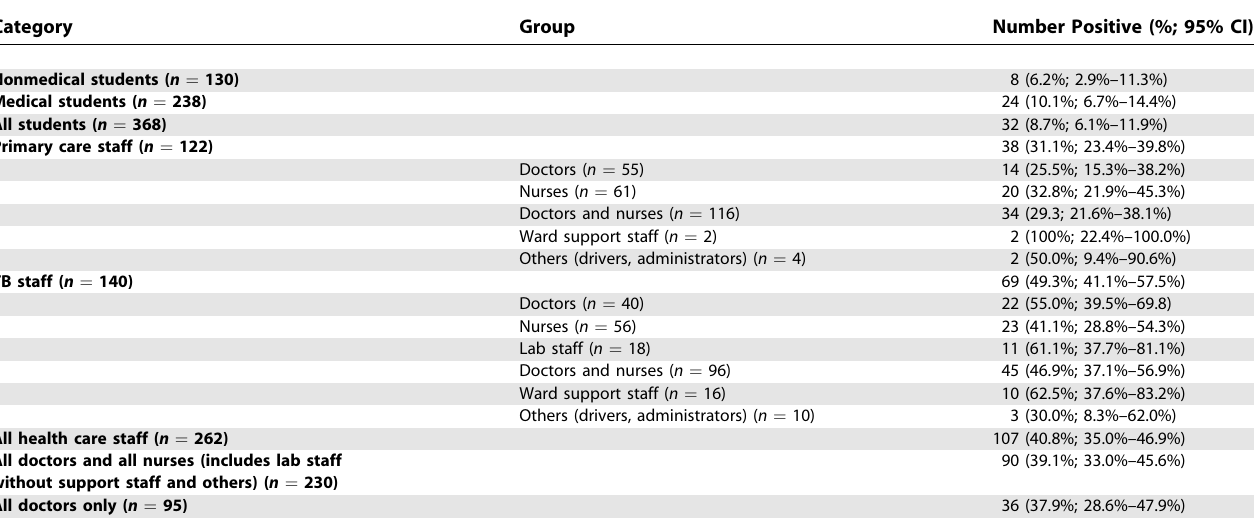
Table 2. Number and Percentage Positive LTBI (IFN- c Assay) by Exposure Group, Samara Oblast Category Group